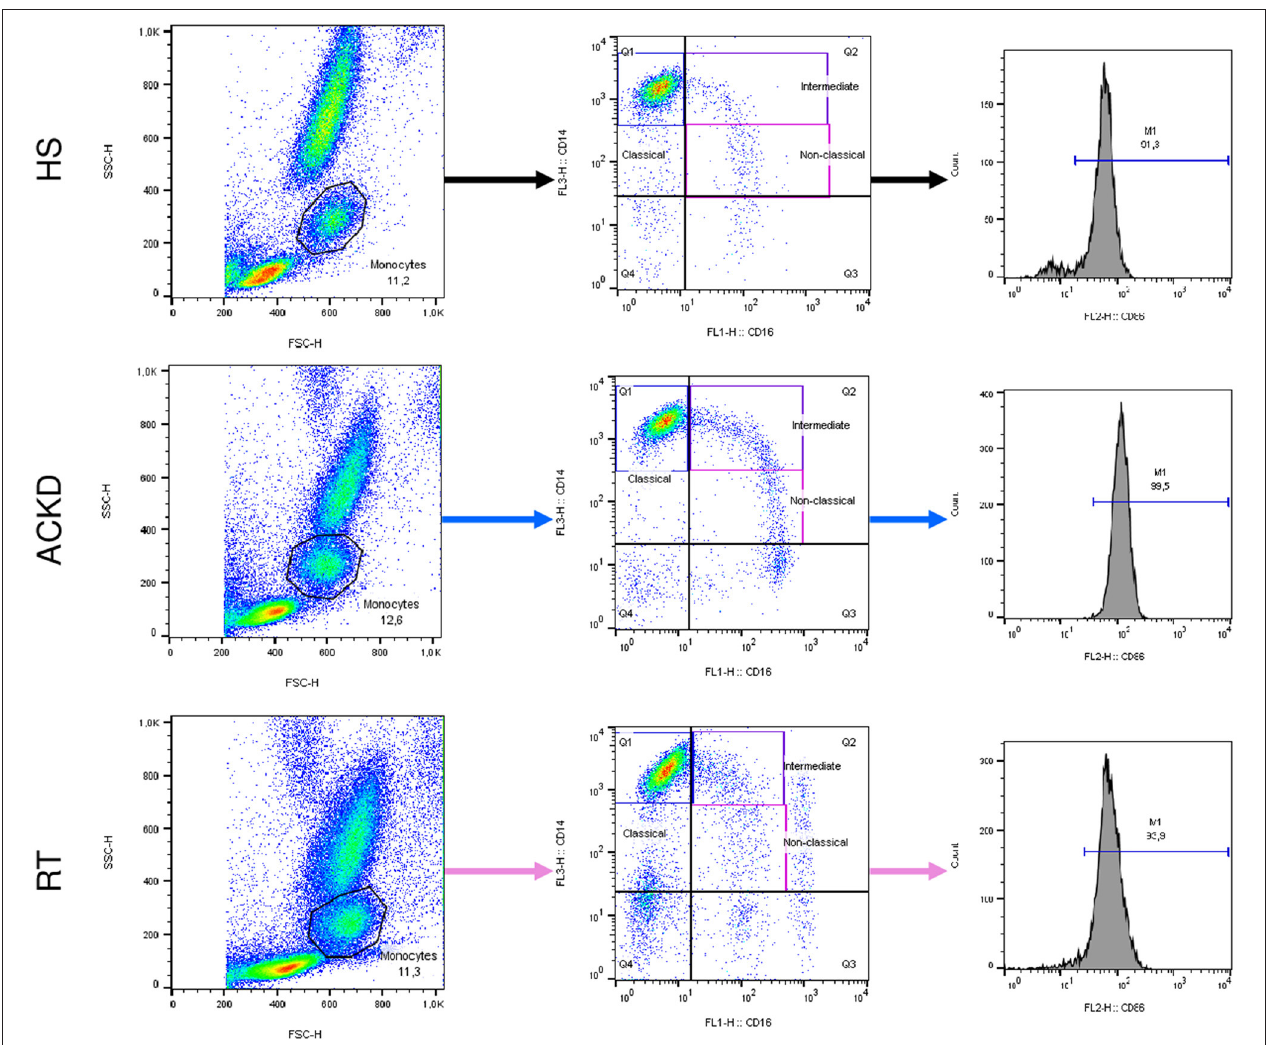
FIGURE 2 | Representative flow cytometry findings of monocyte subsets and CD54/CD86 expression in the three groups: healthy subjects (HS), patients with advanced chronic kidney disease (ACKD), and patients with renal transplantation (RT). Monocyte subpopulations were assessed within the FSC-height/SSC-height. The classical (CD14 ++ CD16–), intermediate (CD14 ++ CD16 + ), and non-classical (CD14 + CD16 + ) monocytes were evaluated using anti-CD16-FITC and anti-CD14–TRICOLOR. For each subpopulation, the expression of CD54 or CD86 was analyzed using anti-CD54-PE or anti-CD86-PE. FITC, fluorescein isothiocyanate; FSC, forward scatter; PE, phycoerythrin; SSC, side